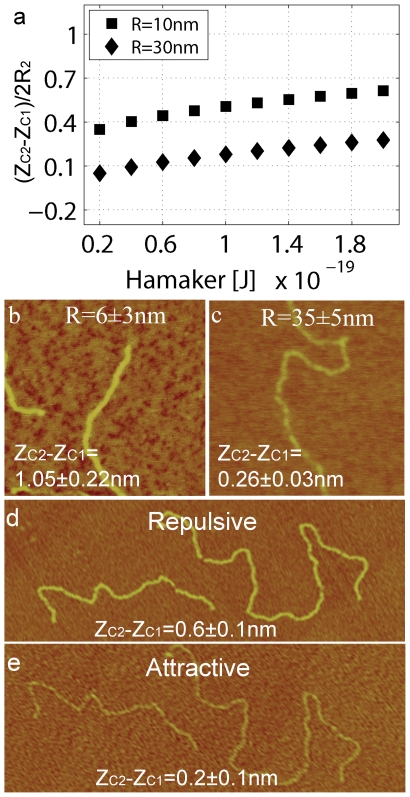
Model versus predictions of apparent height.(a) Model predictions obtained for the normalized apparent height (zc2−zc1)/2R2 as a function of (Hs). The normalized apparent height (zc2−zc1)/2R2 increases with H and decreases with R. Significantly, (zc2−zc1)/2R2 can be smaller than 0.1 or 10% even though all the data has been obtained in the nc mode. In (b) and (c) experimental topographic images of dsDNA molecules on mica show the relationship between R and (zc2−zc1)/2R2. As in the simulations (zc2−zc1)/2R2 increases with decreasing R. In (d) and (e) a single molecule has been imaged in the repulsive and the attractive regimes and the higher value of (zc2−zc1)/2R2 has been obtained in the former. Simulation parameters: A0 = 1 nm, Asp/A0 = 0.95, Es = 0.2 GPa, γ = 50 mJ/m2 (surface energy of the surface) and H = 10×10−20 J (Hamaker of the surface). Experimental parameters: (b–c) A0 = 4 nm and Asp/A0 = 0.9; (d) A0 = 20 nm and Asp/A0 = 0.9; (e) A0 = 2 nm and Asp/A0 = 0.9.